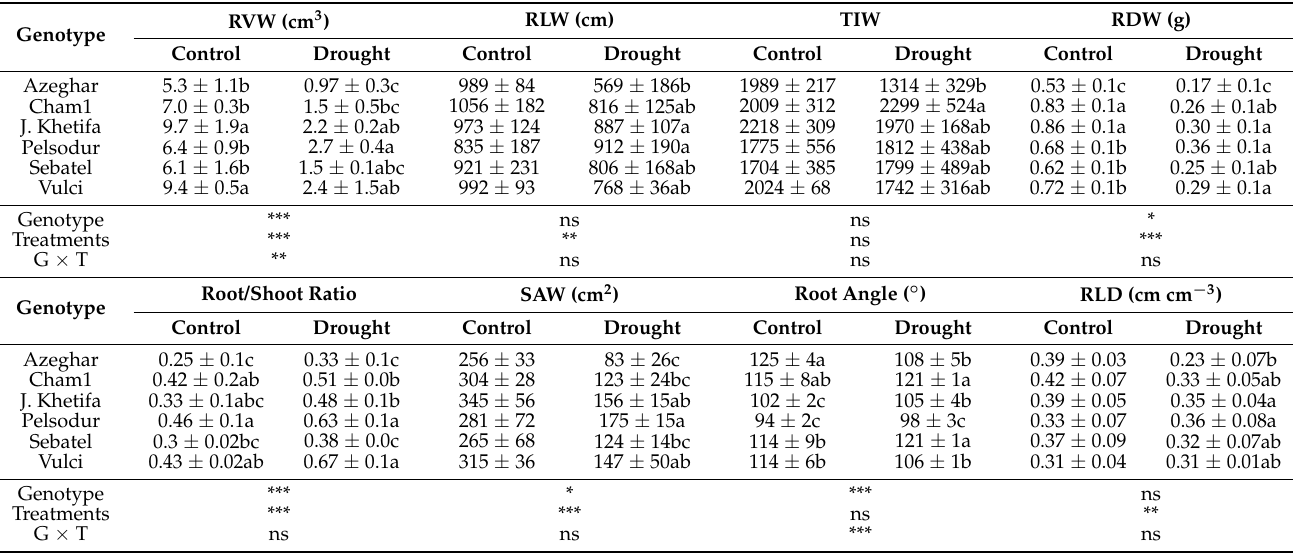
Table 2. Drought effect on the whole root growth and plants